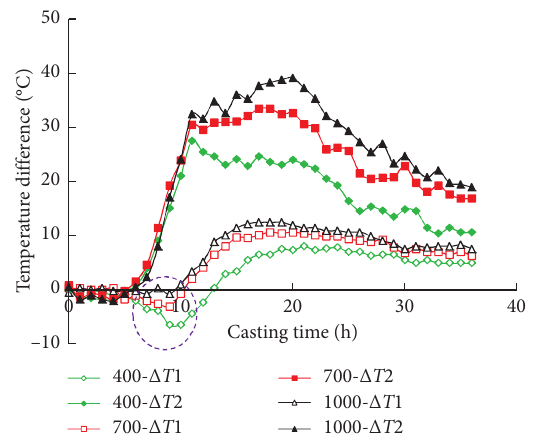
Figure 7: Relationship between the temperature difference and the casting time (pure cement).